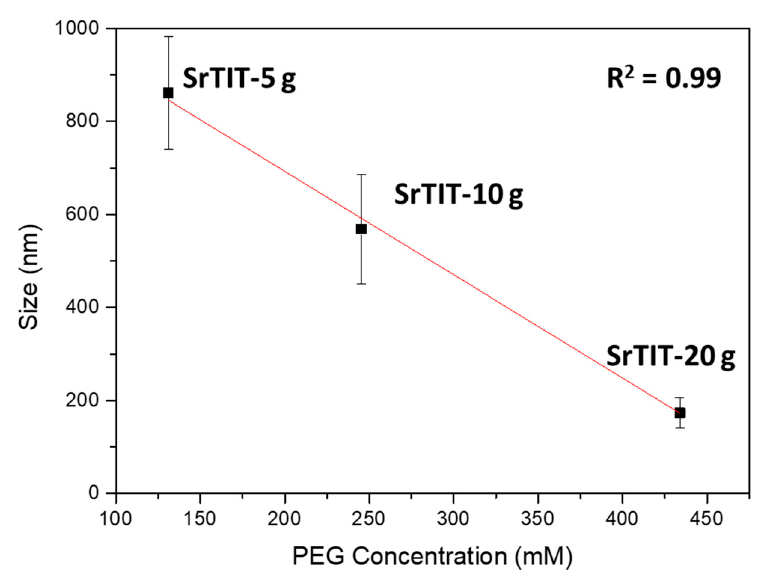
Figure 5. Linear dependence of the particle size on the polyethylene glycol (PEG) concentration.